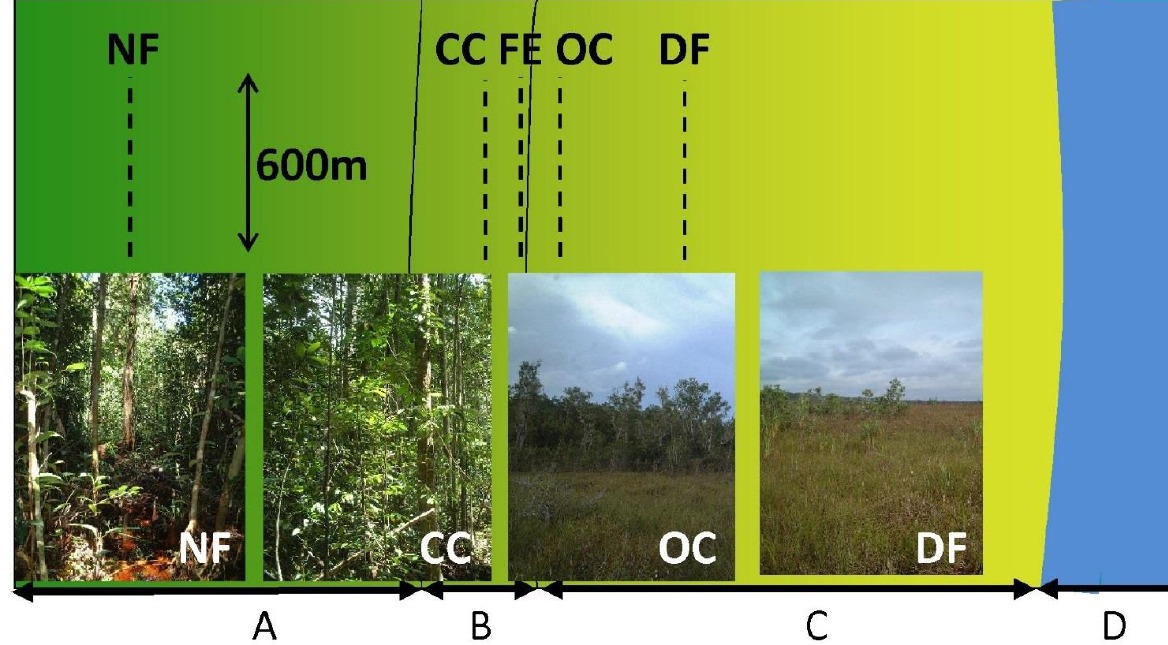
Figure 2. Schematic diagram of the forest study site. The transects are shown as dashed lines, each 600 m long. Transects were positioned parallel to the forest edge in different forest zones: degraded forest (DF), 200 m outside the forest; open-canopy disturbed forest (OC), 50 m outside the forest; forest edge (FE); closed-canopy disturbed forest (CC), 50 m inside the forest; and natural forest (NF in the forested area A), 1 km inside the undisturbed peat swamp forest. The area of degraded sedge swamp (C) was previously riverine forest which was logged and burned decades before this study. The area of transitional forest (B) may be receding farther from the river (D) due to edge effect